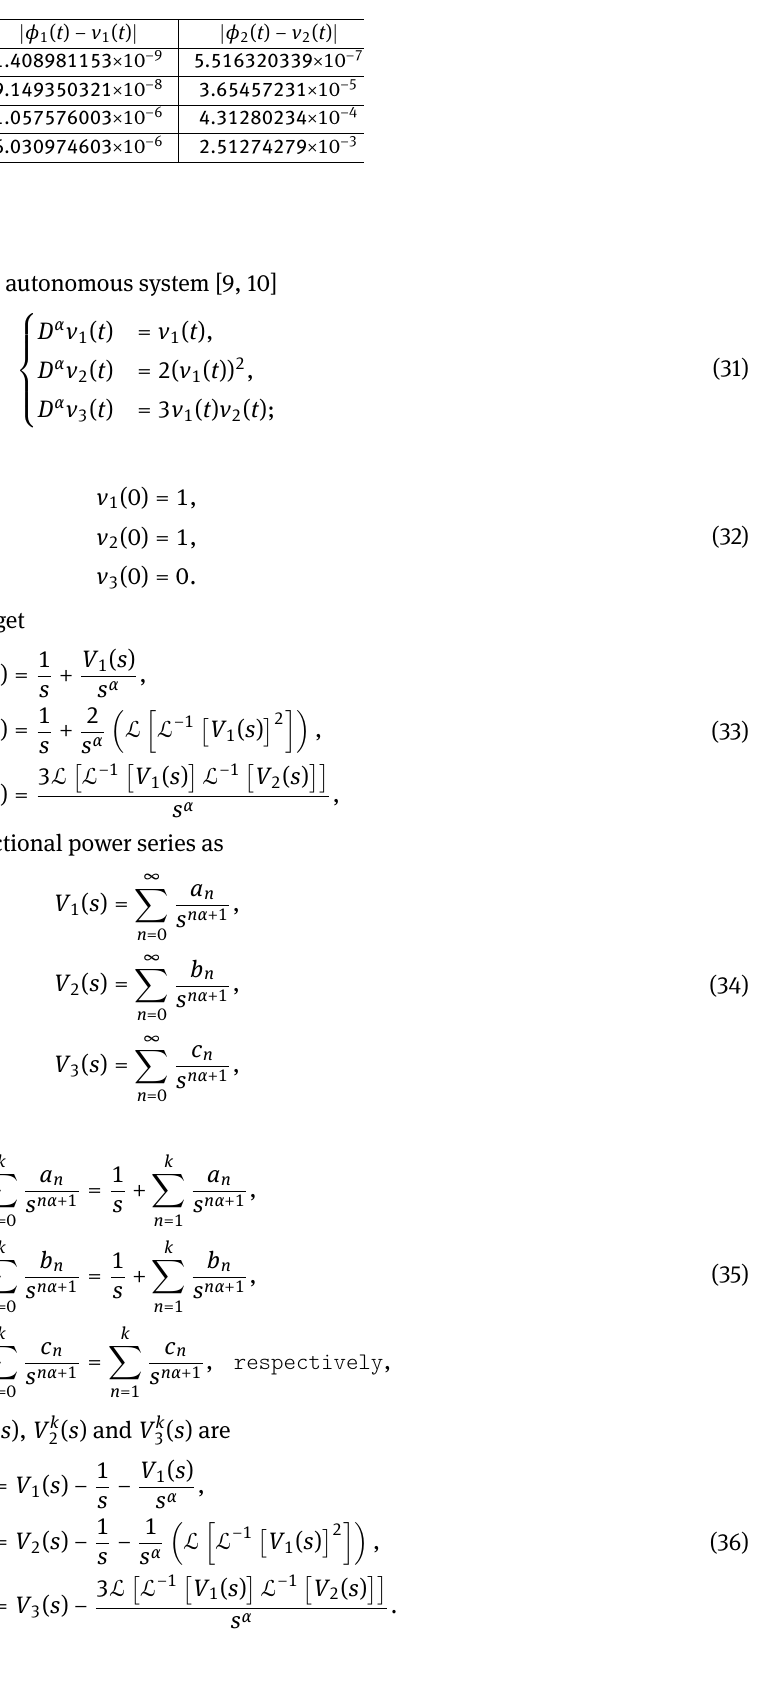
Table 2: Absolute errors: | ϕ 1 ( t ) − ν 1 ( t ) | and | ϕ 2 ( t ) − ν 2 ( t ) | to Example